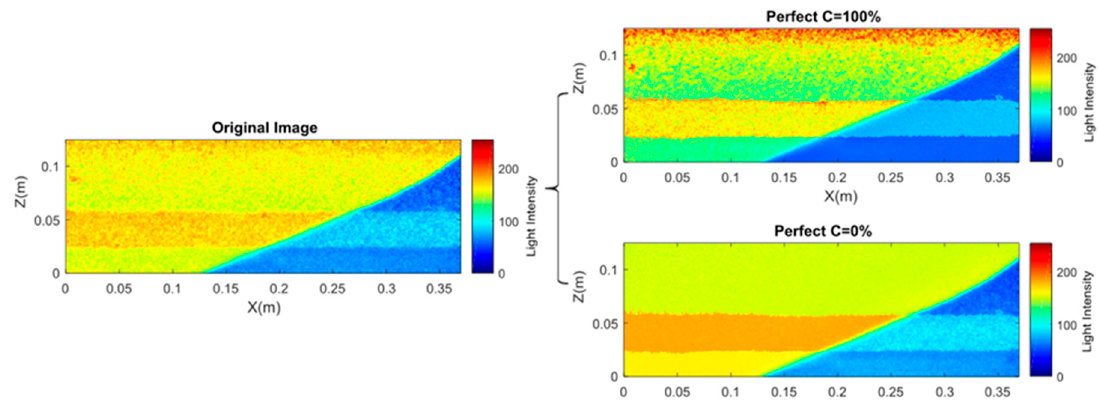
Figure 9. E ff ect of the implementation of BOIM0 and BOIM100 on a SWI image of the Layered2 Figure 9. Effect of the implementation of BOIM0 and BOIM100 on a SWI image of the Layered2 aquifer.